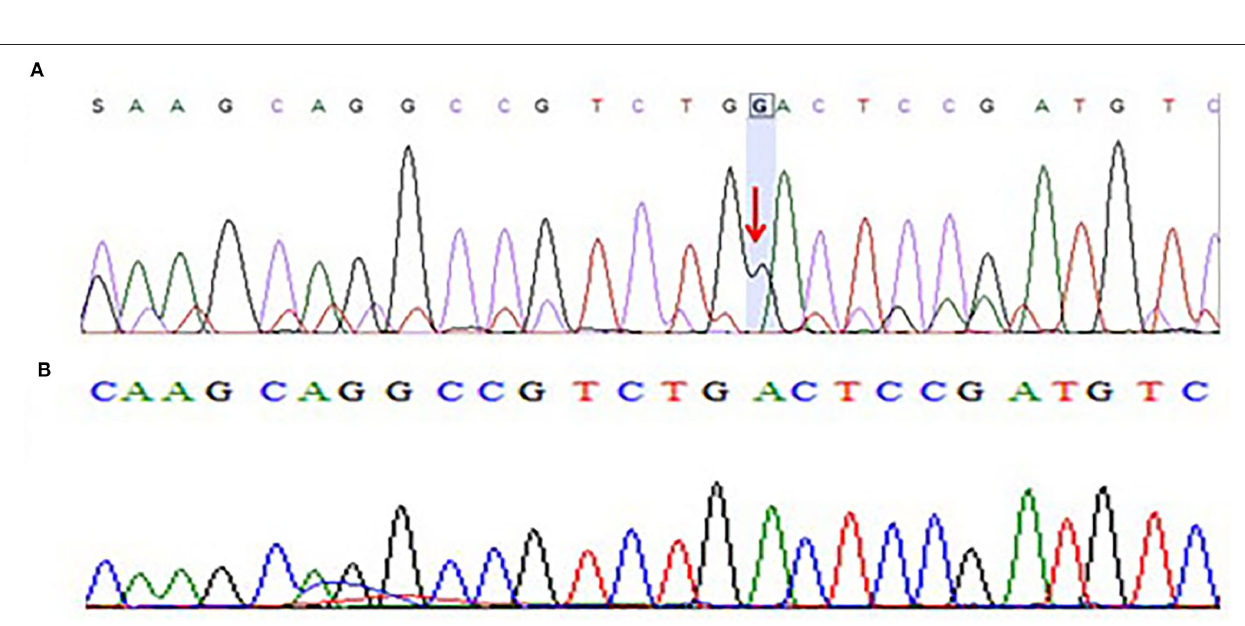
Frontiers in Pediatrics | www.frontiersin.org 7 June 2022 | Volume 10 | Article